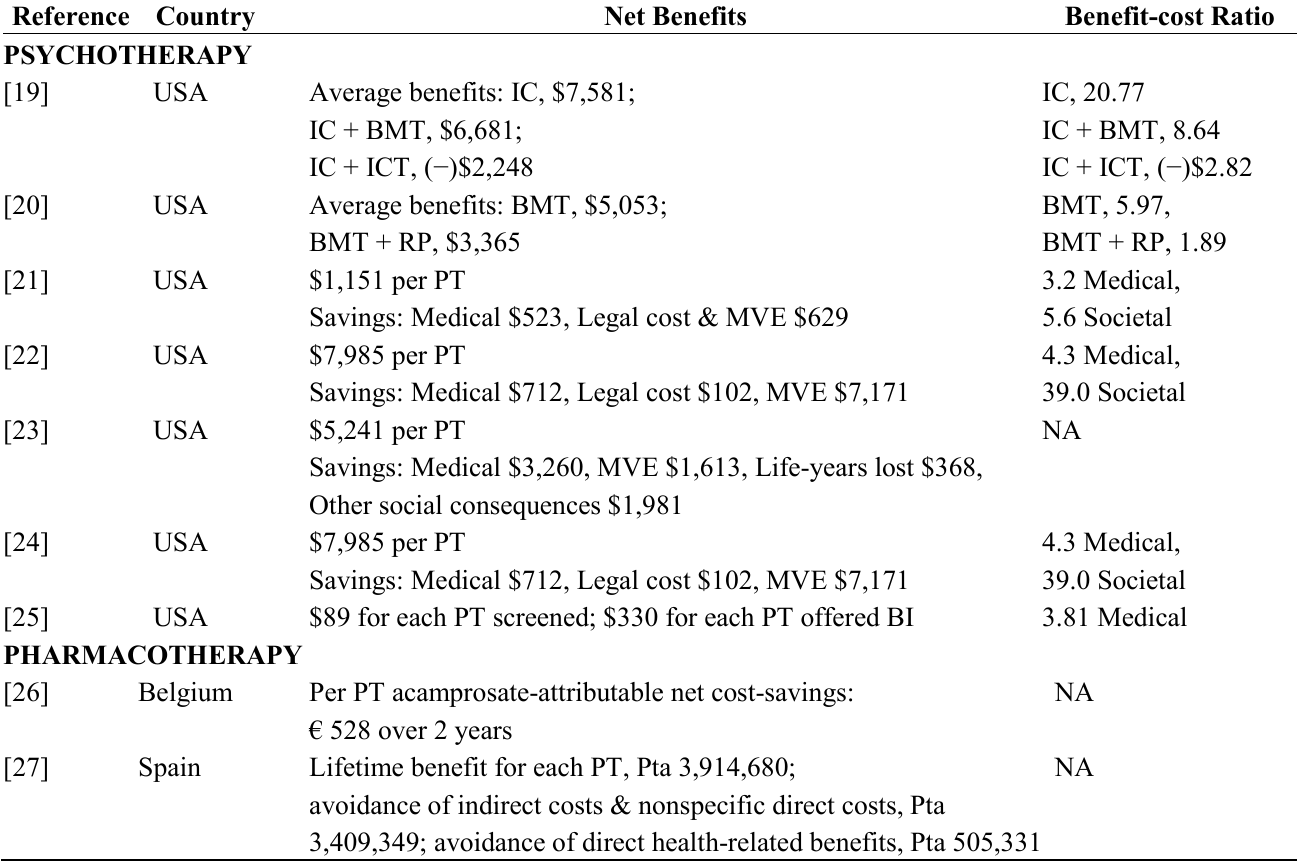
Table 2. Net benefit or cost-benefit ratio for alcohol dependence